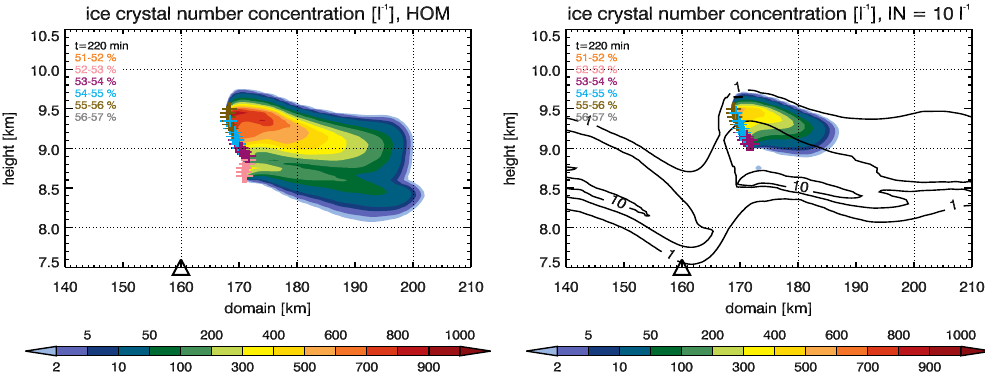
Figure 6. Ice crystal number concentration for simulation HOM (left) and 10 IN (right) for t = 220min. Colours denote the homogeneously frozen ice crystals and black lines the heterogeneously frozen ice crystals, with lines for 1, 5, 10 and 20L − 1 . The crosses show where RHi exceeds the critical supersaturation for homogeneous freezing at this point in time, and the colours show the amount of supersaturation.